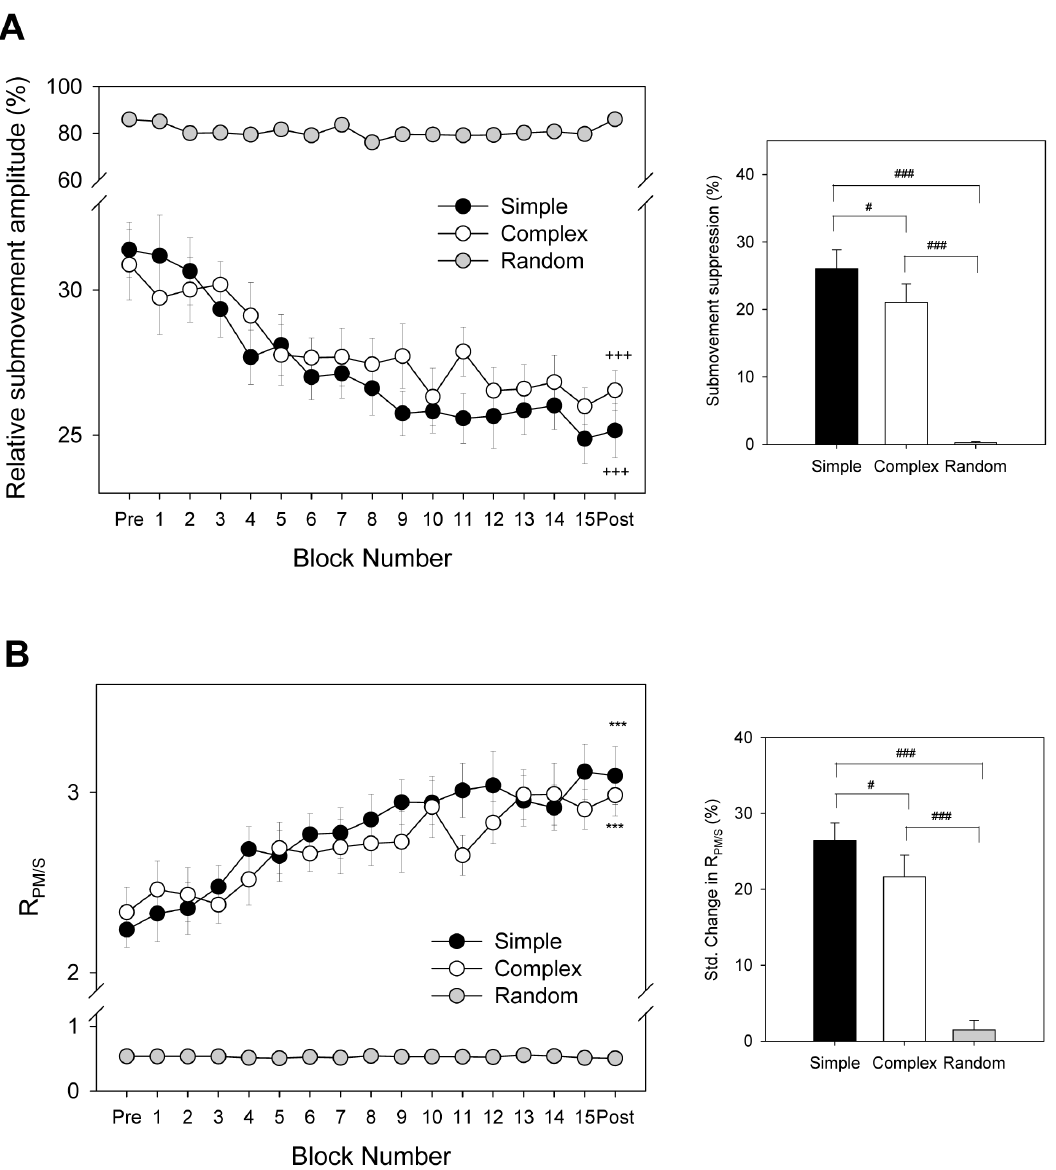
Figure 4. Contrast of mean evolutional and standardized changes in submovement amplitude among three practice protocols. (A) Relative submovement amplitude in percentage, (B) Amplitude ratio of primary movement to submovement (R PM/S ) ( +++ : pre-test . post-test, p , 0.05; *** : post-test . pre-test, p , .001)( # : significant difference between protocols, p , 0.0167; ### : significant difference between protocols, p ,